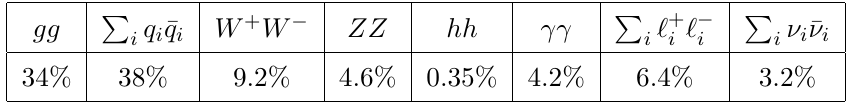
Table 1 . Relative branching fractions of KK gravitons to SM particles, ignoring phase space e(cid:11)ects. where the dimensionless parameter (cid:15) , which vanishes in the rigid limit ( (cid:22)